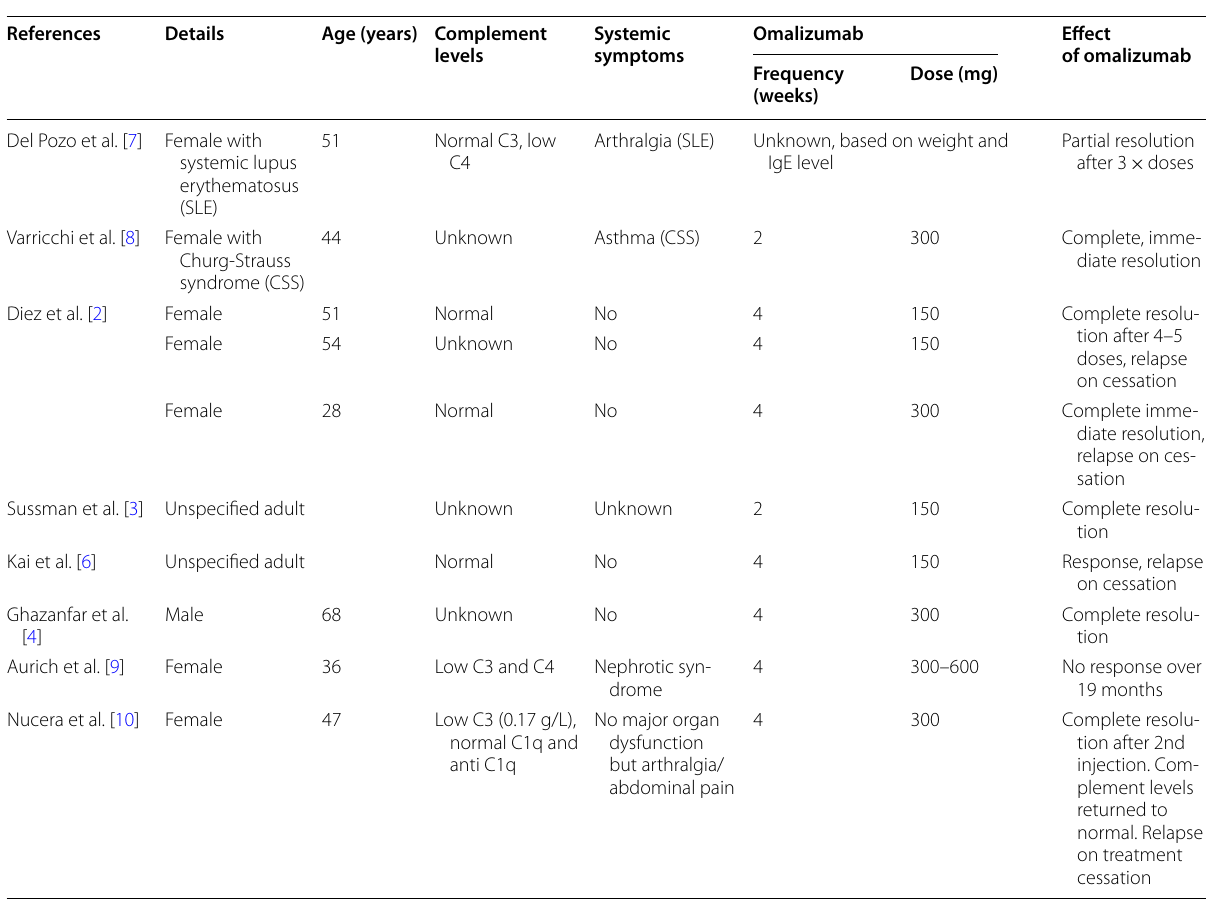
Table 1 Published cases of omalizumab use in urticarial